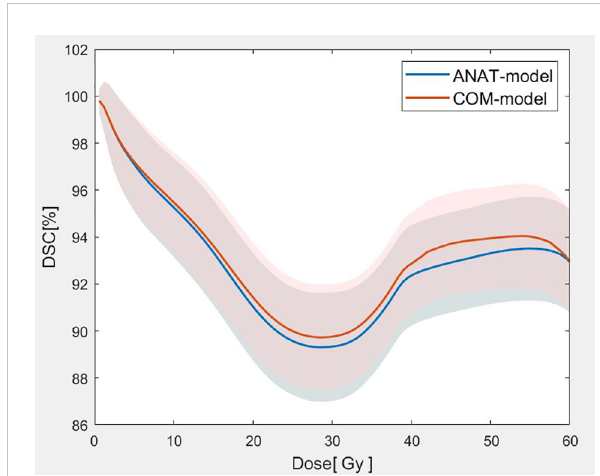
FIGURE 4 Comparison of the mean DSC values with of the isodose volumes between the two models (The solid lines represent the mean value of DSC for 2 models at each dose point and the corresponding shaded areas represent the values of standard